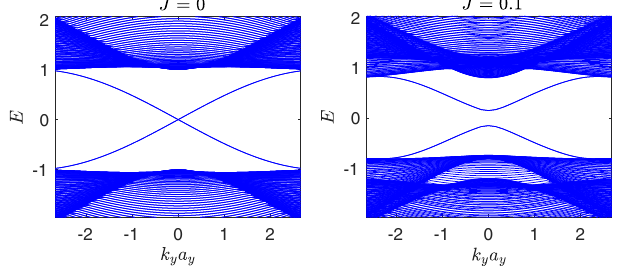
FIG. 5. Comparison between J ¼ 0 (left) and J ¼ 0 . 1 (right) with t ¼ 1 , λ ¼ 0 . 2